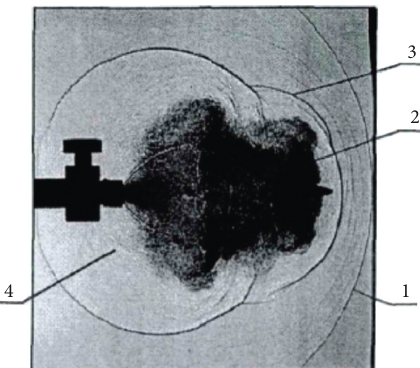
Figure 1: High-speed shadow photo of muzzle flow field, 7.62mm ballistic gun. 1: initial shock wave; 2: propellant gas flow; 3: pro- pellant gas shock wave; 4: impulsive noise